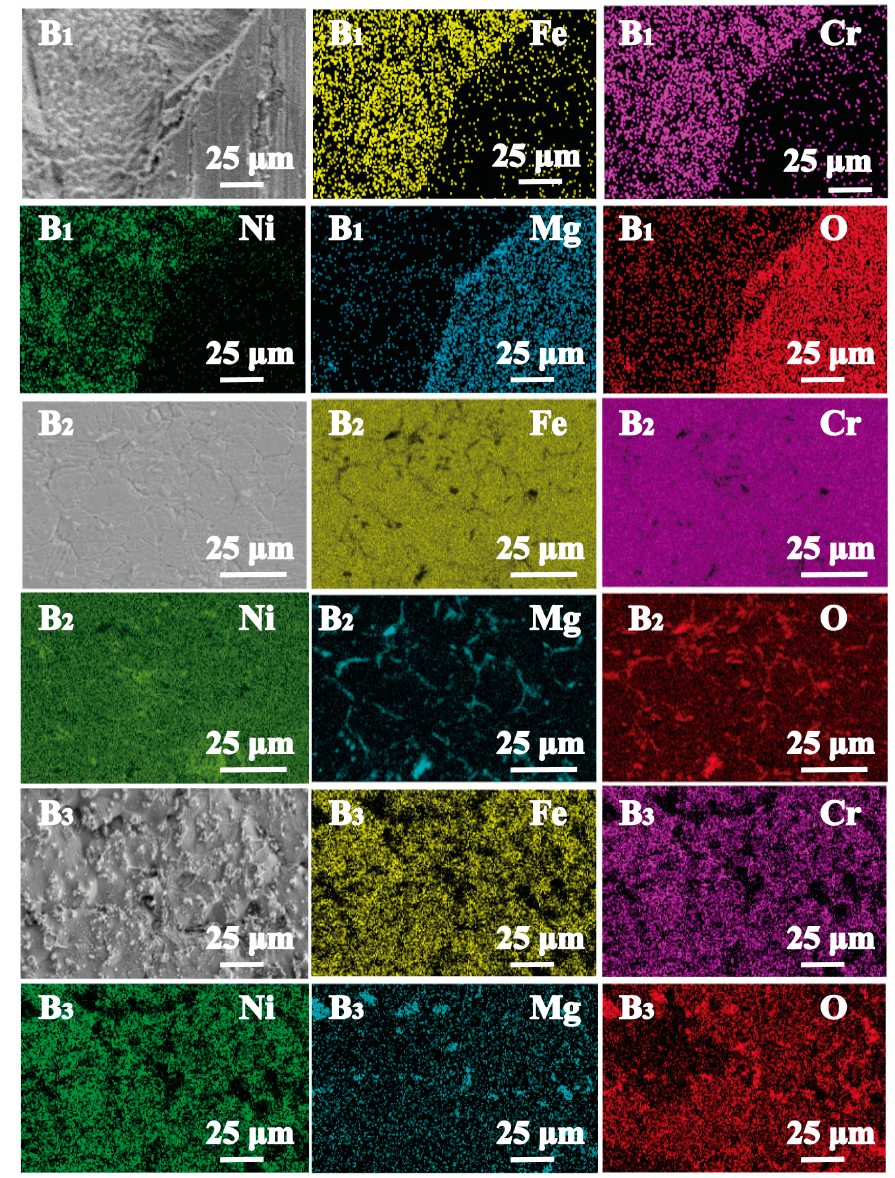
Figure 5. Element distribution of 316SS exposed in purified salt under Ar for 100 hrs at 500 °C (B 1 ),600 °C (B 2 ), and 700 °C (B 3 ).